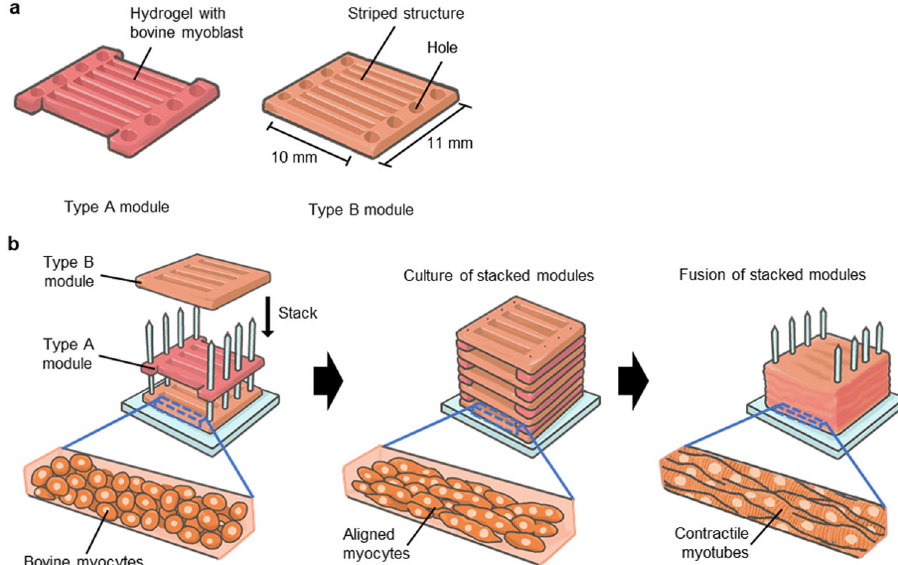
Fig. 1 Construction process of millimetre-thick bovine muscle tissue. a Illustration of two types of myocyte-laden hydrogel modules composed of holes to allow immobilisation of the pillar and seven or eight striped structures to promote alignment of myocytes. b Conceptual illustration of the fabrication process for a millimetre-thick bovine muscle